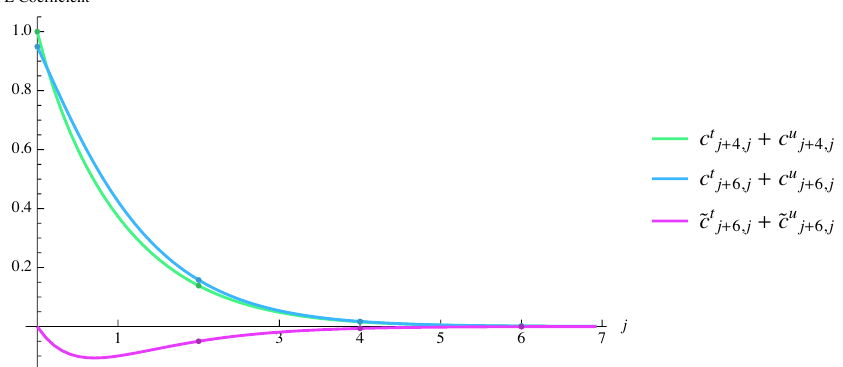
Figure 9. The even-spin inversion data plotted as a function of spin. The dots along the curve correspond to the coefficients appearing in the discrete OPE decomposition (eq. (6.7)). In N = 4 SYM, the coefficients agree with the analytic formula for all j ≥ 0 . The odd-spin coefficients are